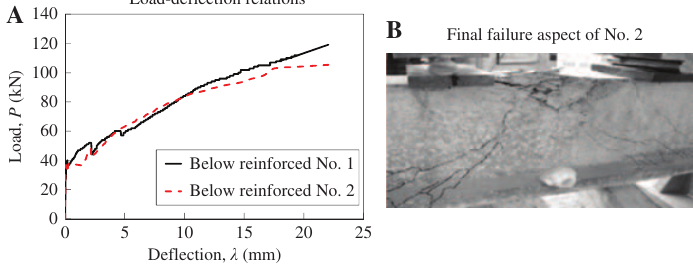
Figure 5 Below reinforced concrete beams.